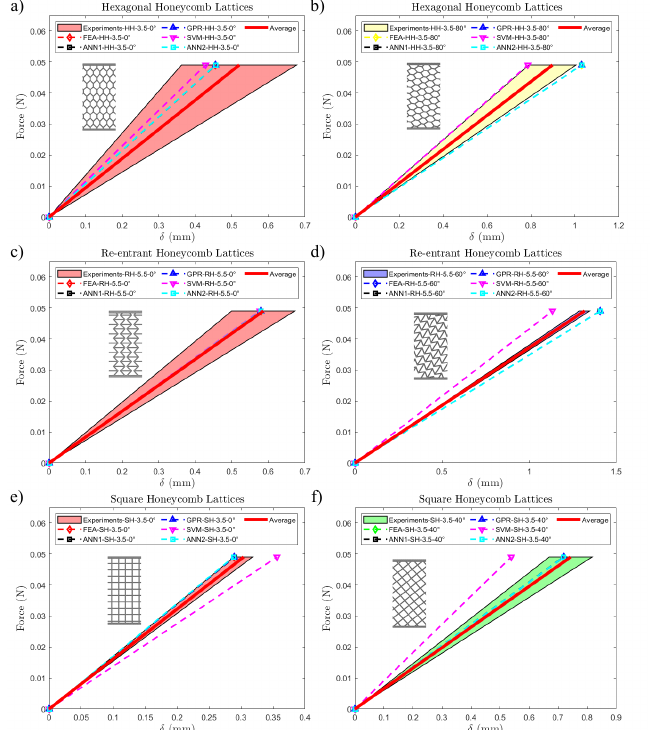
Figure 13. Force-displacement curves from experimental, simulated, and ML predictions. ( a ) Stiffest responses from the compliant cross-axis joints with hexagonal lattice-flexure hinges. ( b ) Least stiff responses from the compliant cross-axis joints with hexagonal lattice-flexure hinges. ( c ) Stiffest responses from the compliant cross-axis joints with re-entrant lattice-flexure hinges. ( d ) Least stiff responses from the compliant cross-axis joints with re-entrant lattice-flexure hinges. ( e ) Stiffest responses from the compliant cross-axis joints with square lattice-flexure hinges. ( f ) Least stiff responses from the compliant cross-axis joints with square lattice-flexure hinges.